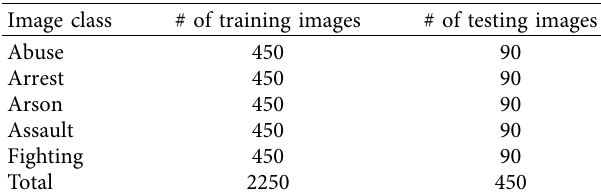
Table2: proposed LSTM